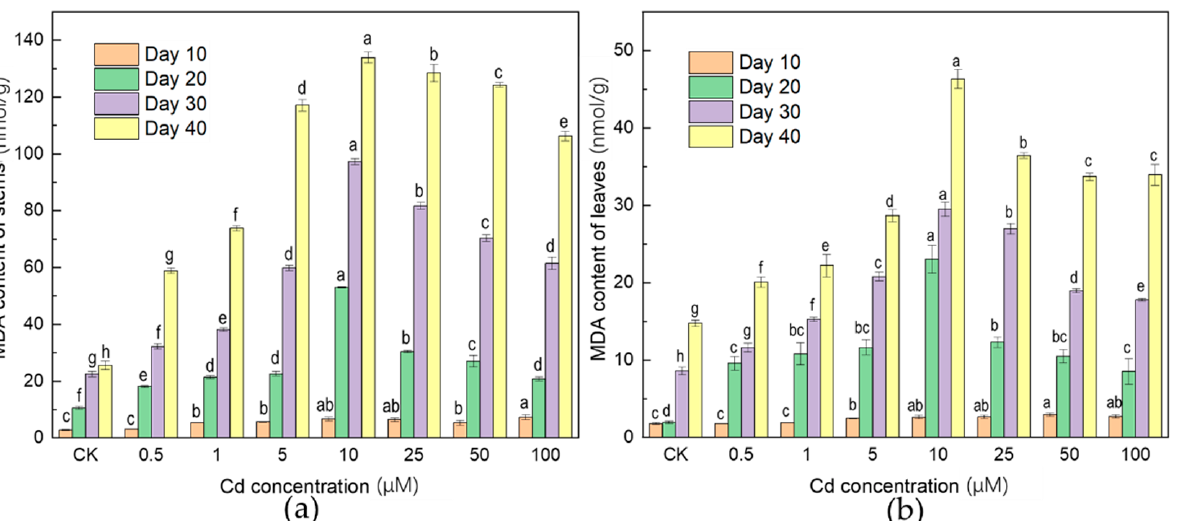
Figure 1. The effect of different concentrations of Cd on the growth rate (FW) and plant height of A. selengensis . ( a ) growth rate (FW), ( b ) plant height. The results are means ± SD ( n = 3), lower letters mean significant differences ( p < 0.05) between different Cd concentrations at the same treatment time.